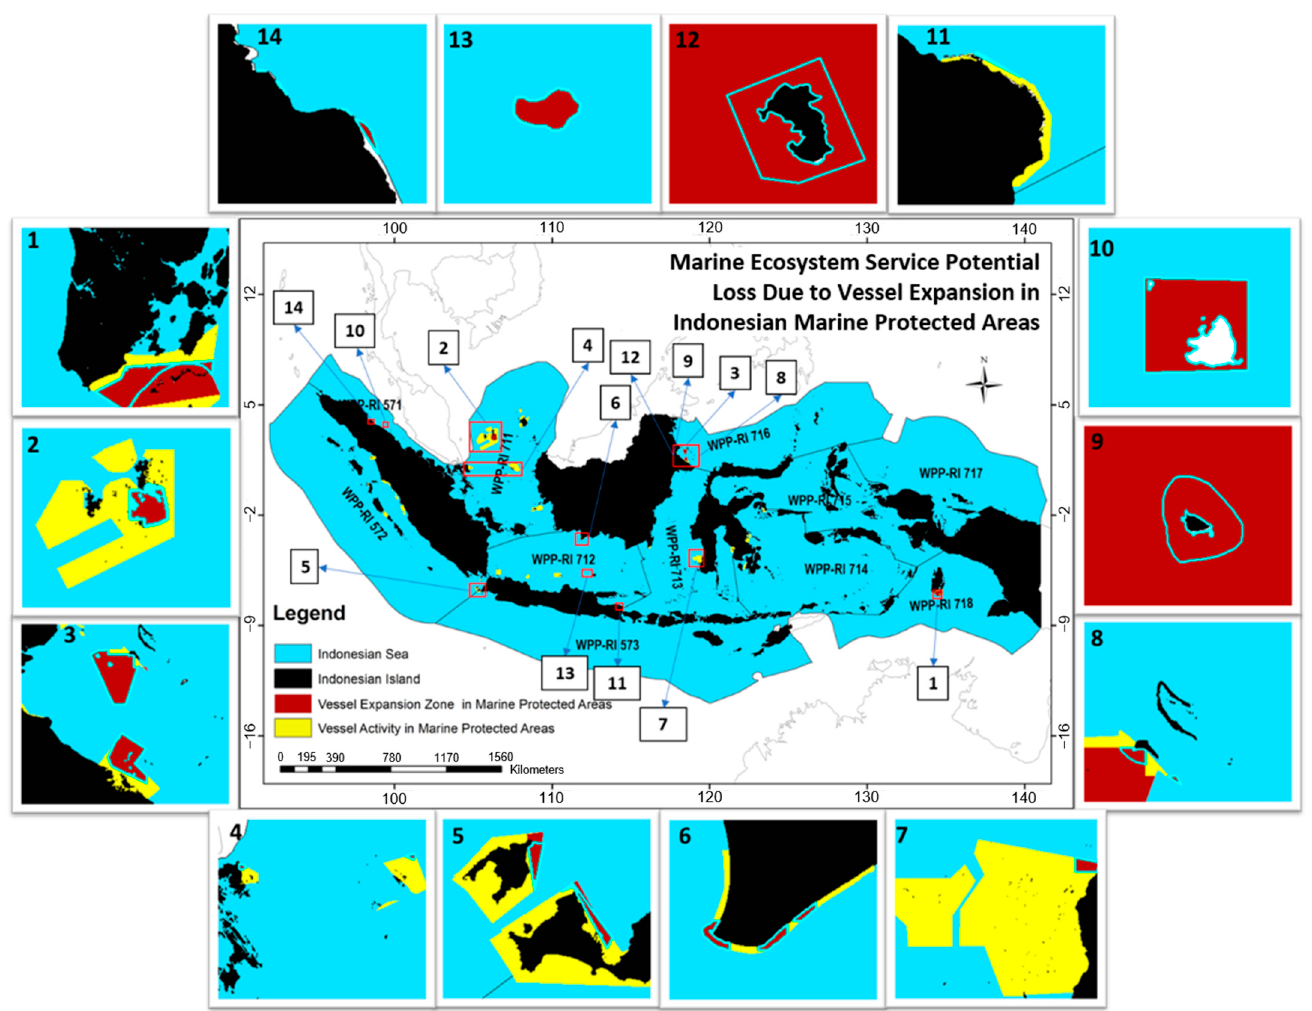
Figure 8. Map showing the vessel expansion zone in 14 Indonesian MPAs.